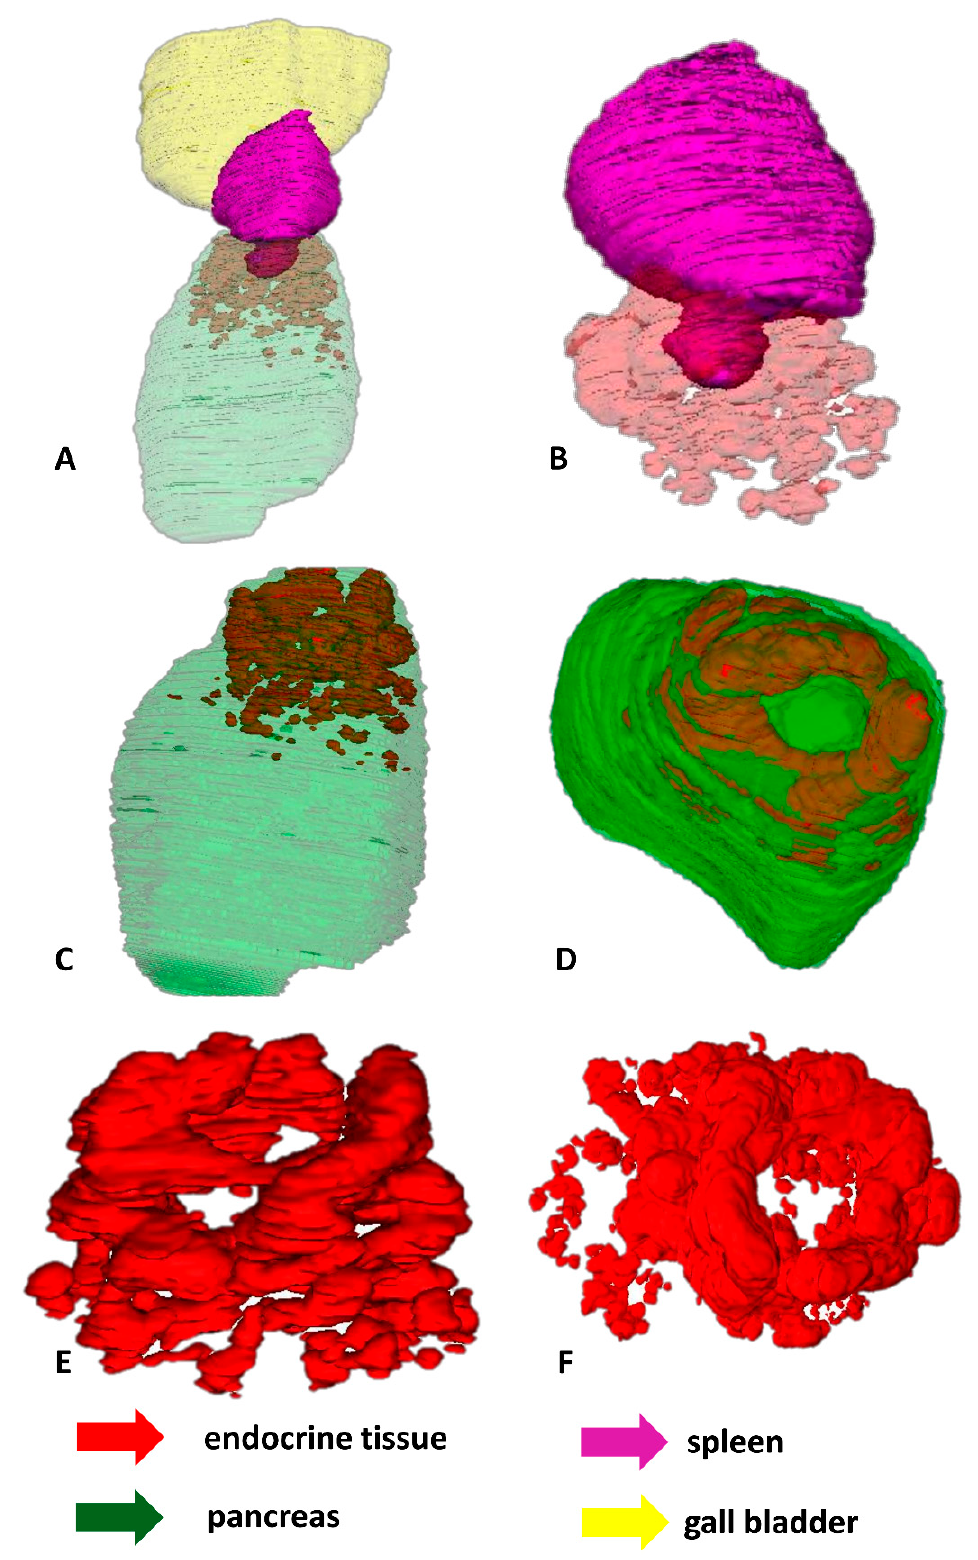
Figure 7. 3D reconstructions of the pancreatic islet arrangement within pancreas of the grass snake embryos at developmental stages IX–XI. ( A – C , E ) lateral view, ( D , F ) top view. Note ring forming by pancreatic islets and splenic “bulb”.